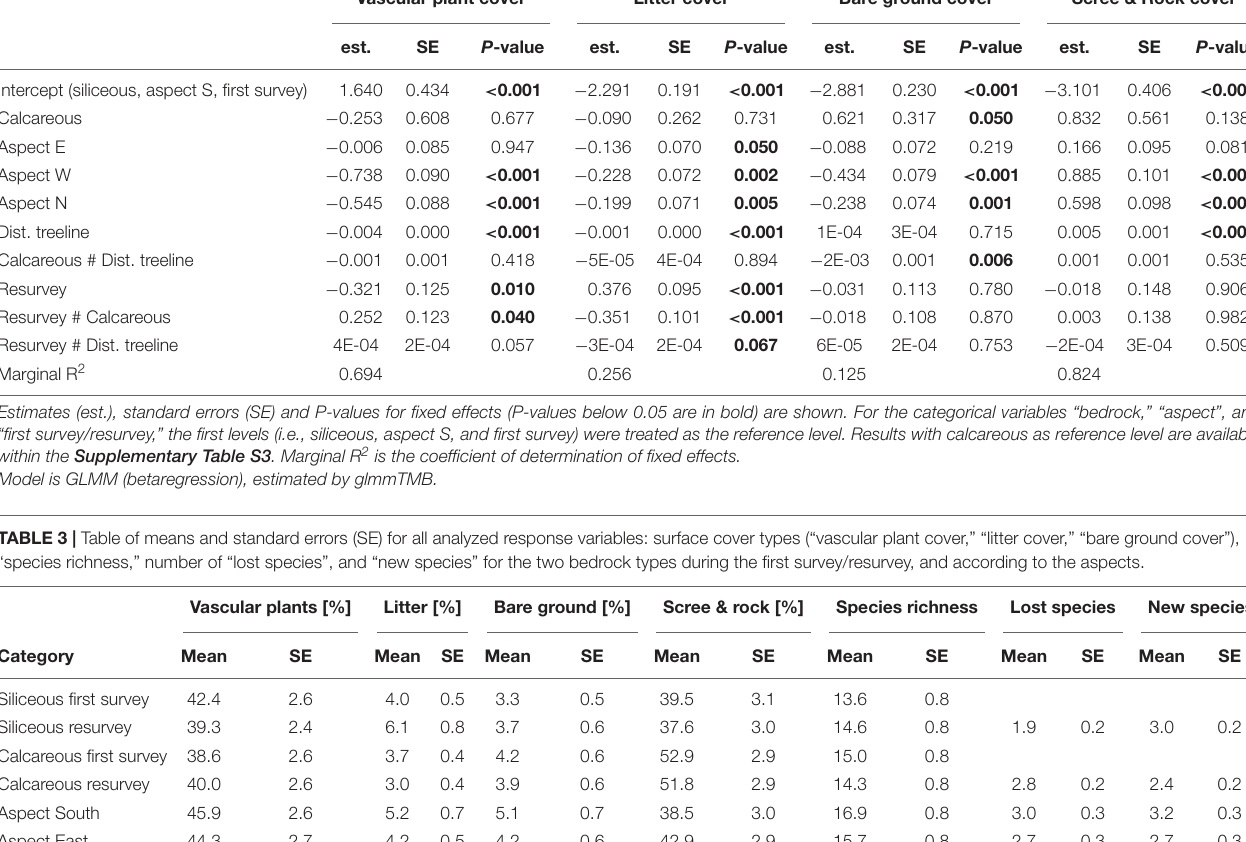
TABLE 2 | Effects of bedrock, aspect, distance to treeline, first survey/resurvey, and selected interactions on the cover of vascular plants, litter, bare ground, and scree & rock. Vascular plant cover Litter cover Bare ground cover Scree & Rock cover